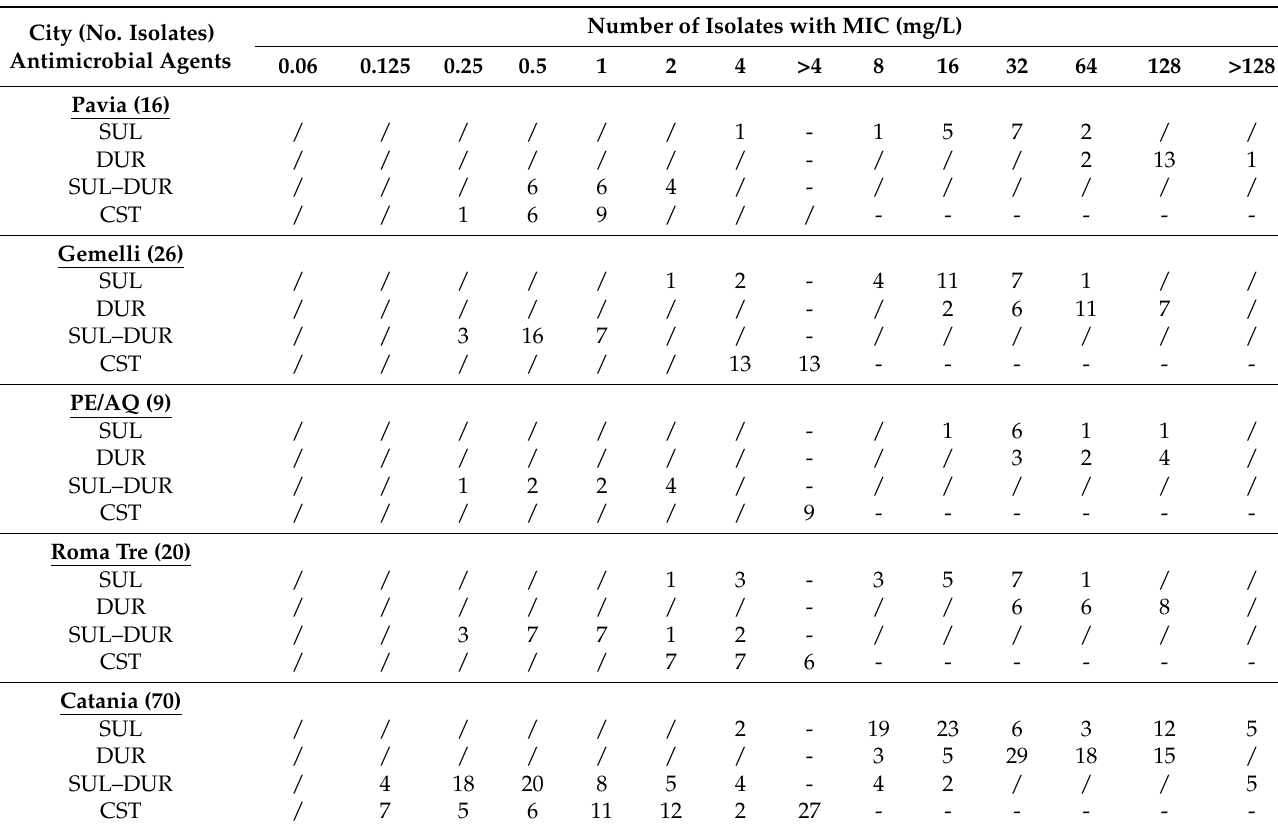
Table 2. MIC distribution of sulbactam–durlobactam and comparators against 141 CR Ab isolates by location of the clinical microbiology